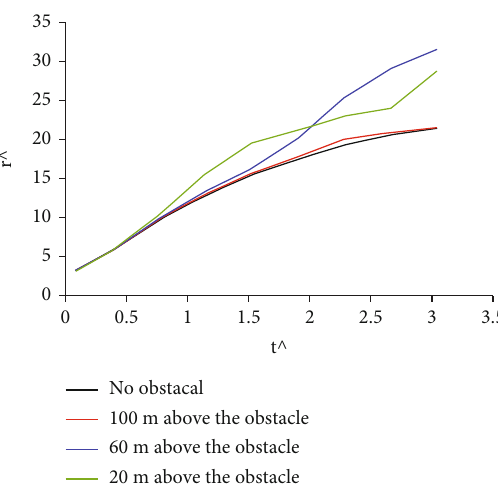
Figure 18: Variation of circulation.